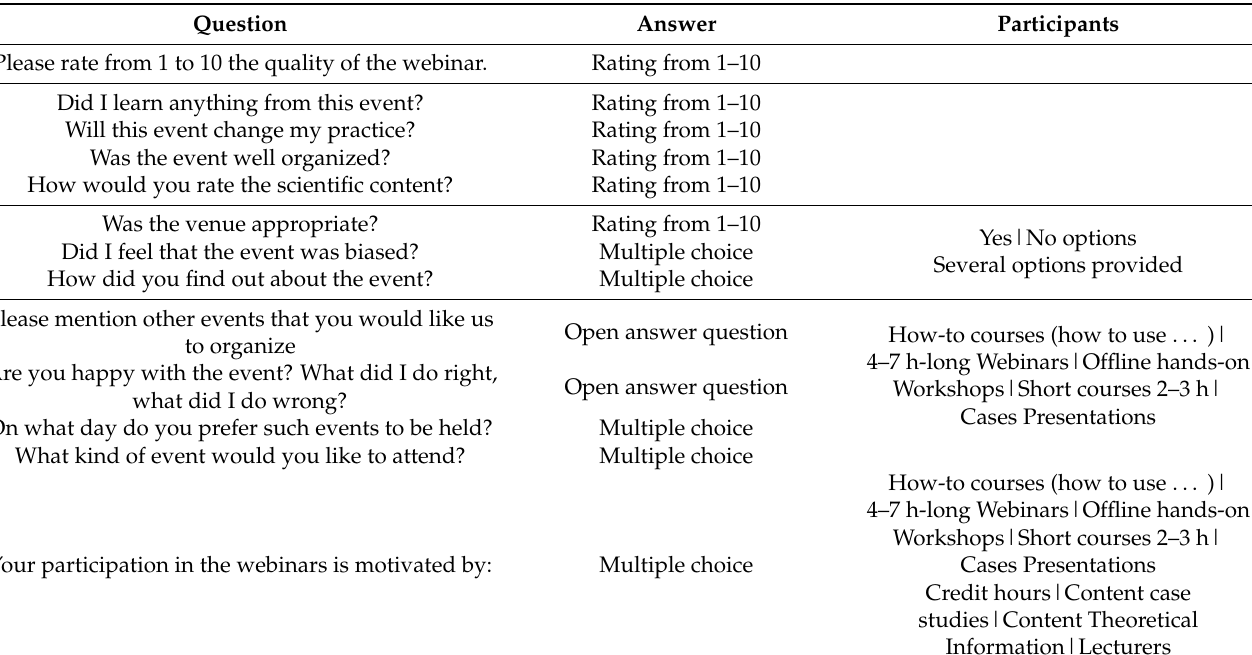
Table A1. Questionnaire